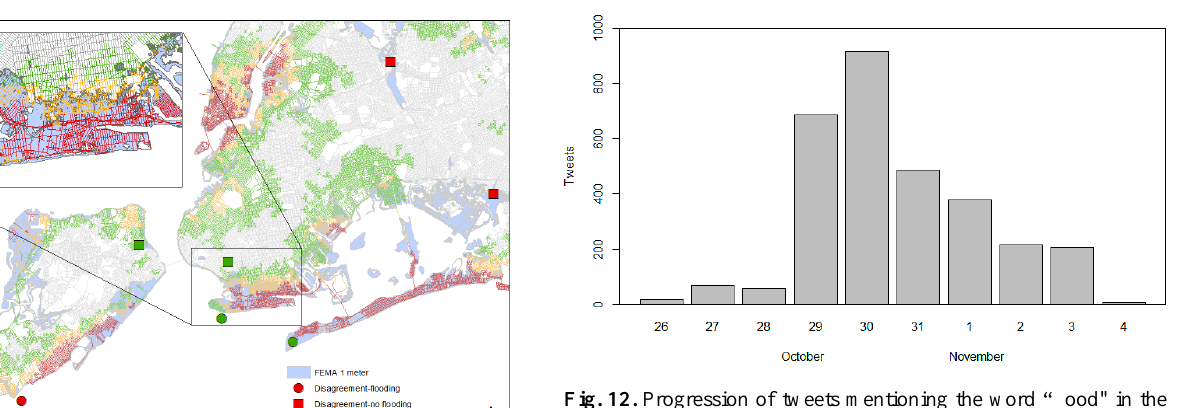
Fig. 12. Progression of tweets mentioning the word “flood" in the New York City